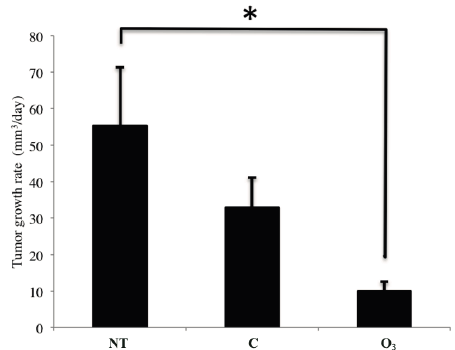
Figure 6. The effect of local administration of ozonated water on rates of tumor growth. * p < 0.05 compared to the NT group by using the Tukey–Kramer test. NT: non-treatment group; C: local administration of sterile distilled water group; O 3 : local administration of ozonated water